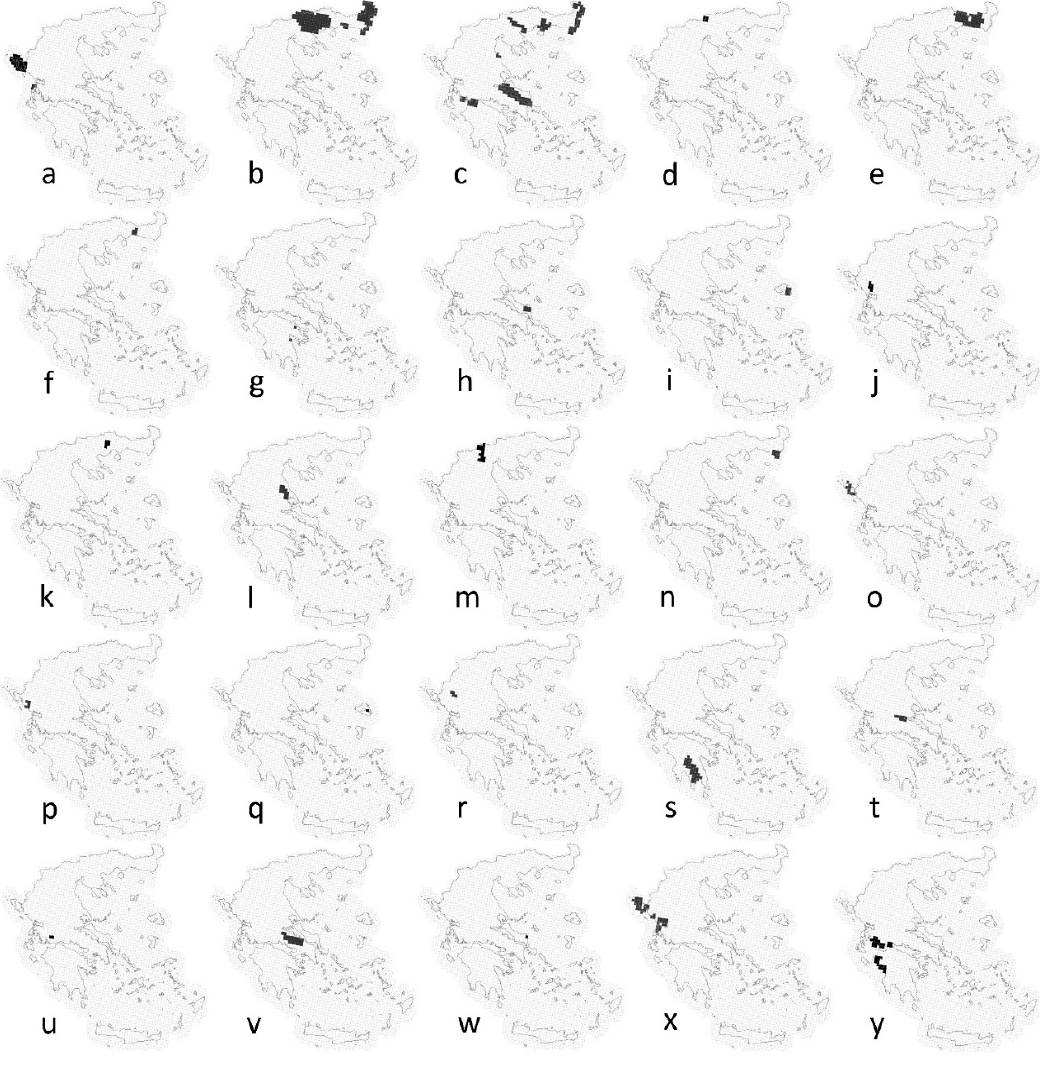
Figure 2. Geographical ranges of CR fish species in Greece projected in 1 x 1 km grid cells. Background colored areas show terrestrial (green) and marine (blue) EU Natura 2000 protected areas. Codes: (a) A. naccarii; (b) A. stellatus ; (c) A. sturio ; (d) A. macedonicus ; (e) A. vistonicus ; (f) A.vistonica ; (g) A.almiriensis ; (h) B. euboicus ; (i) B. pergamonensis ; (j) C. graecus ; (k) C. hellenicus ; (l) C. stephanidisi ; (m) Eudontomyzon sp. Almopaios ; (n) H. huso ; (o) K. goerneri ; (p) K. milleri ; (q) O. theophilii ; (r) P. epiroticus ; (s) P. laconicus ; (t) P. hellenicus ; (u) S. economidisi ; (v) S. graecus ; (w) Squalius. sp. Evia ; (x) V. letourneuxi ; (y) V. robertae .